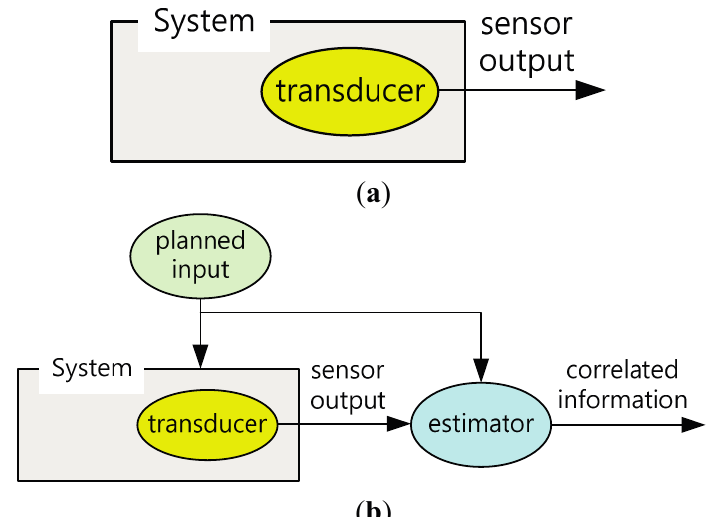
Figure 2. Active sensing. ( a ) Conventional sensing; ( b ) Estimation of correlation of sensor outputs with the planned